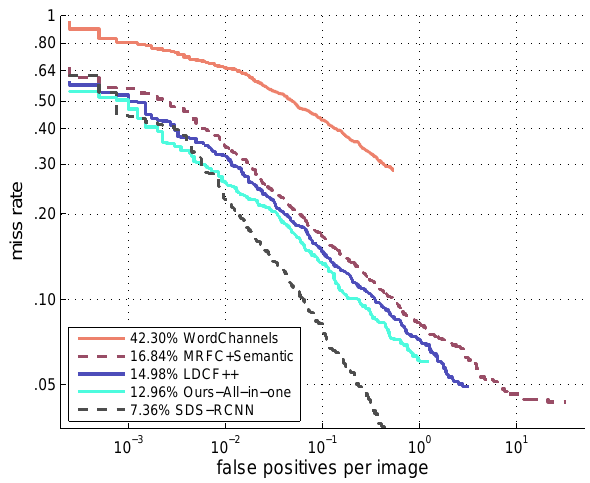
Figure 9. Comparison with the top methods and single scale feature maps-based methods on the Caltech dataset. Our method achieves the lowest miss rate for the whole FPPI range in all the non deep learning methods.